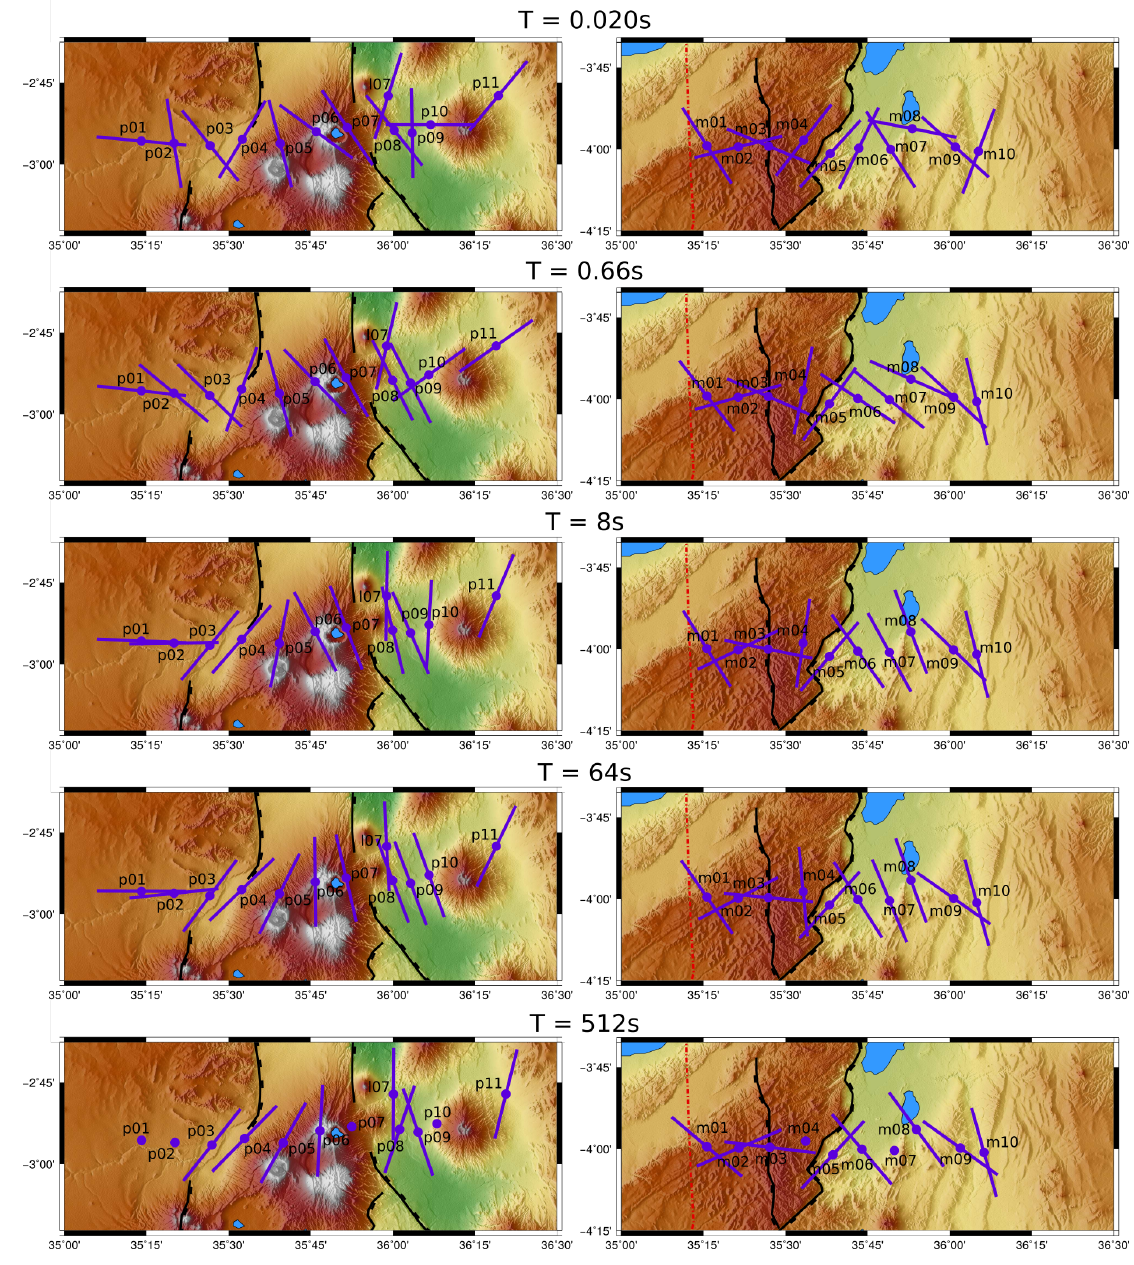
Figure A5. Maximum electrical direction (MED) for both northern ( left ) and southern ( right ) profiles at 5 distinct periods represented on a portion of the Figure 1. See text for